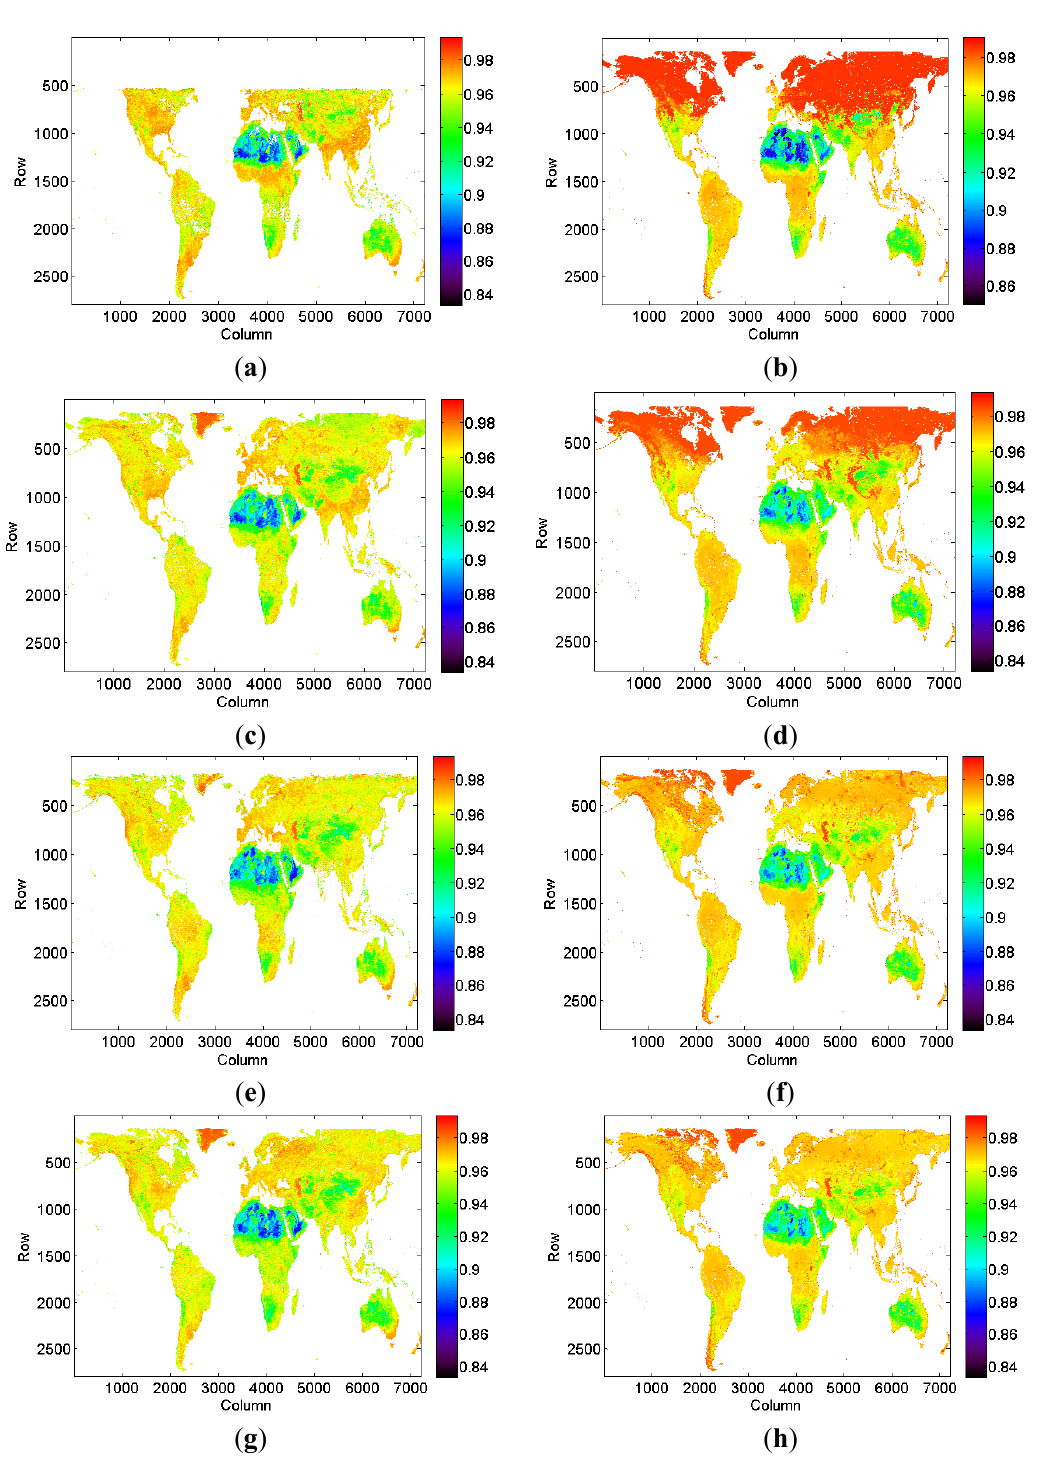
Figure 6. Geographical distribution of global UWIREMIS BBE and GLASS